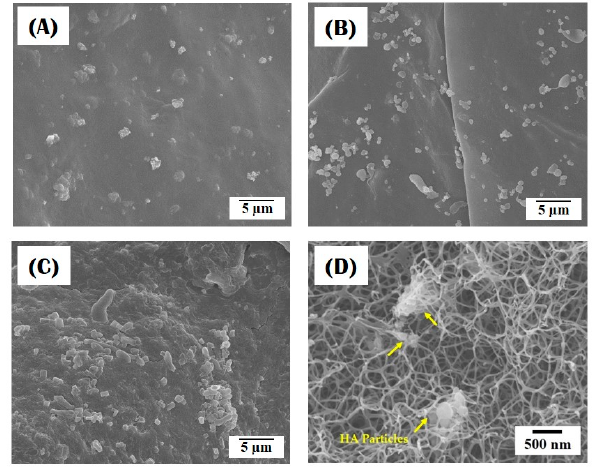
Figure 4. Representative FE-SEM images showing the distribution of HA particles in nanofibrous collagen/HA composite microspheres synthesized with different levels of HA: ( A ) 10 wt %; ( B ) 15 wt %; ( C , D ) 20 wt